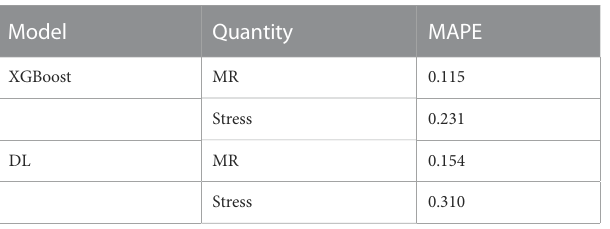
TABLE 3 MAPE for different ML models using the testing